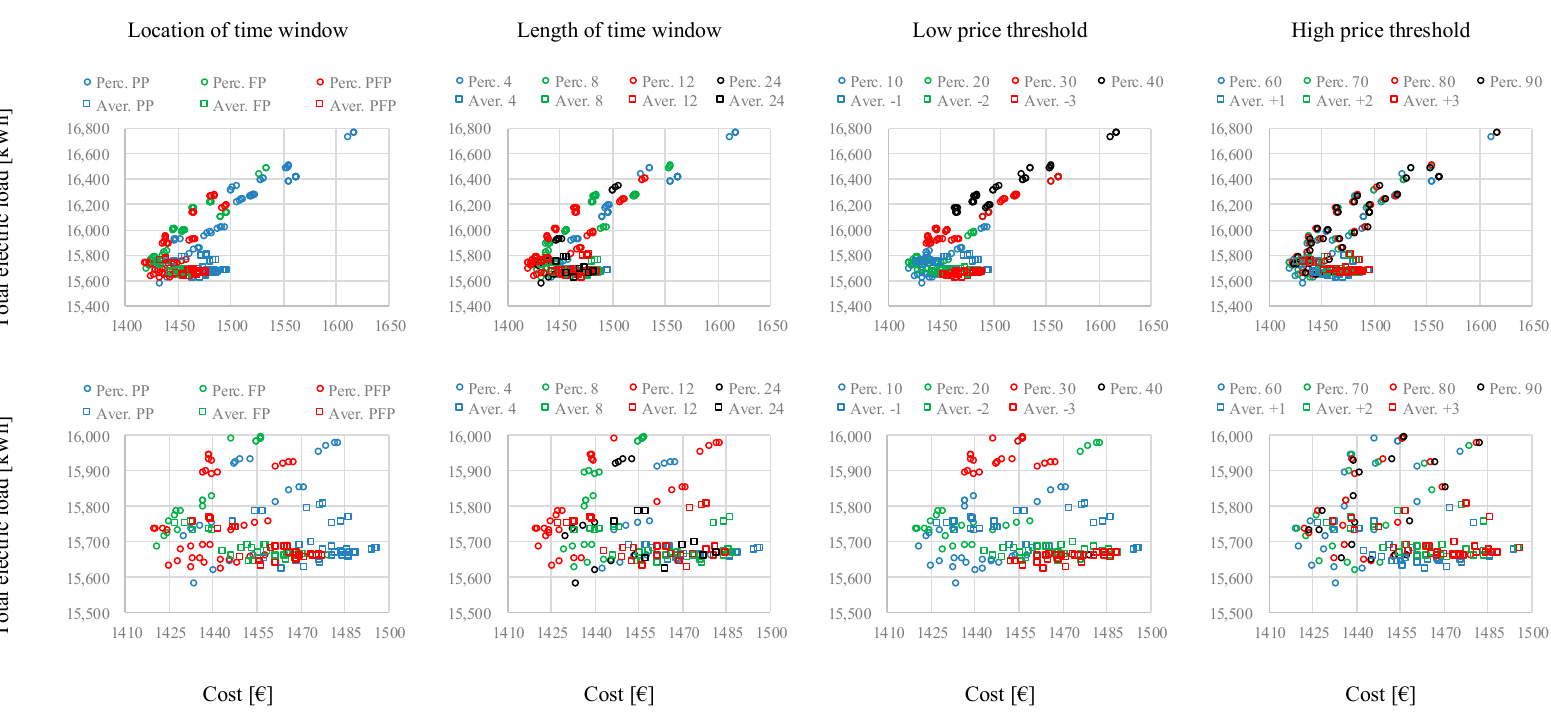
Figure 5. The cost and total electric load results for the different criteria for price evaluation by the RBC: the location of the time window (i.e., PP, FP, or PFP), the length of the time window (i.e., 4, 8, 12, or 24 h, the threshold for low price classification, and the threshold for high price classification. The top row shows the full set of results, while the bottom row zooms into the results with low cost and load.